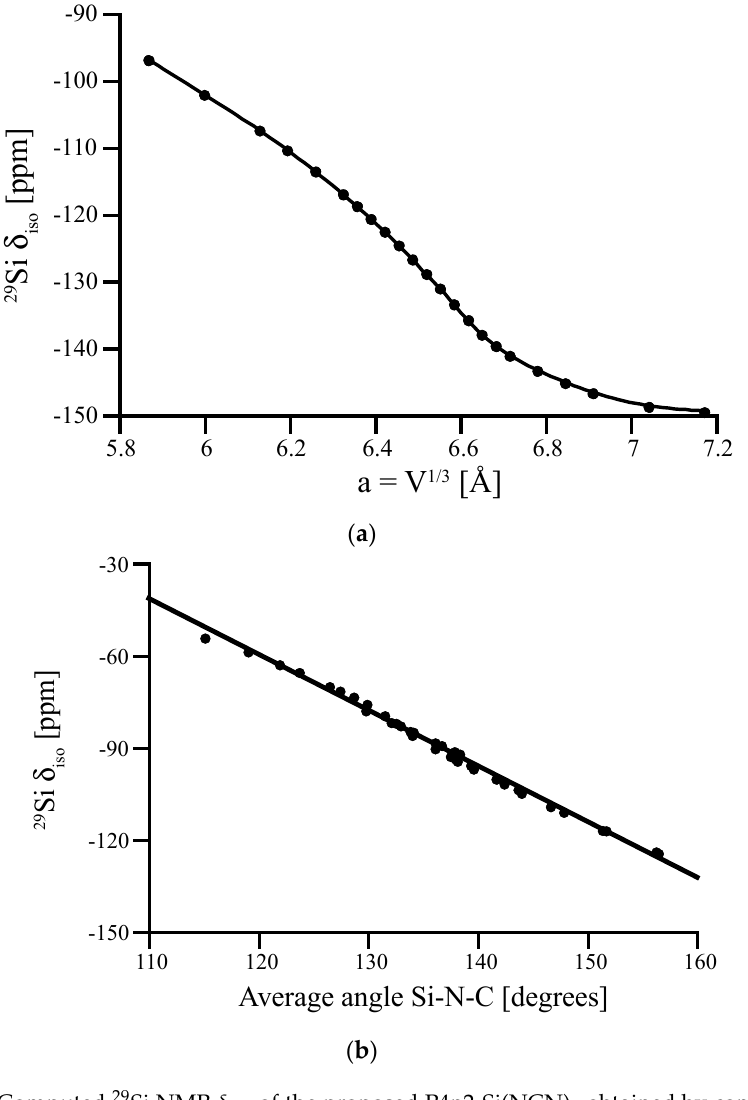
Figure 6. ( a ) Computed 29 Si NMR δ iso of the proposed P4n2-Si(NCN) 2 obtained by contracting the volume of the structure. The chemical shift is plotted versus the corresponding “cubic” lattice parameter, a = V 1/3 . ( b ) The relation between the computed 29 Si NMR δ iso and the average Si-N-C angle around Si site. Experimental data of δ iso in Si(NCN) 2 is − 103 ppm [44].